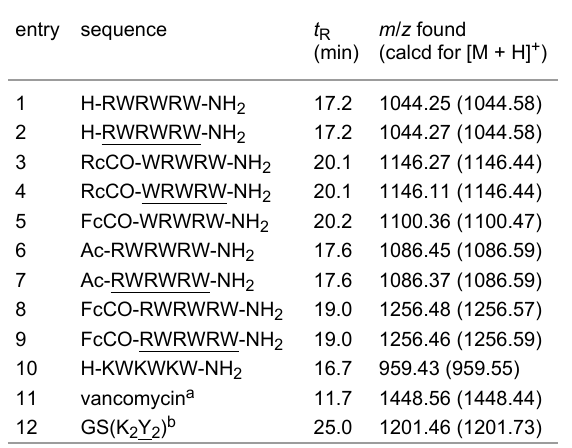
Table 1: Overview of the studied sequences and analysis thereof (retention times and m / z values). Underlined amino acids are D-enan- tiomers, not underlined residues are L-enantiomers; FcCO refers to ferrocenoyl and RcCO to ruthenocenoyl (Figure